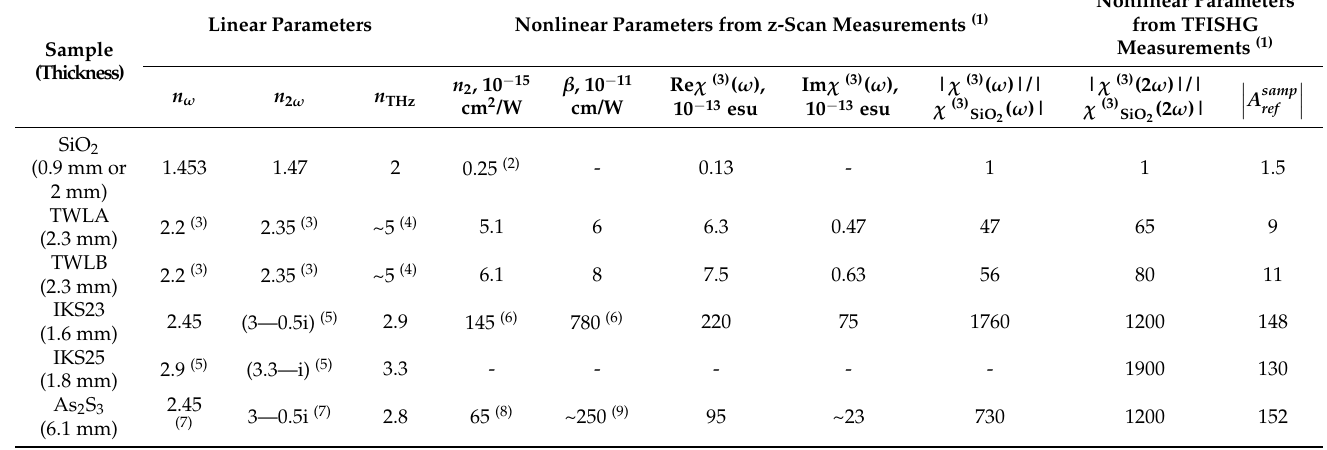
Table 1. Linear and nonlinear parameters of the studied samples. Nonlinear Parameters from z-Scan Measurements (1)